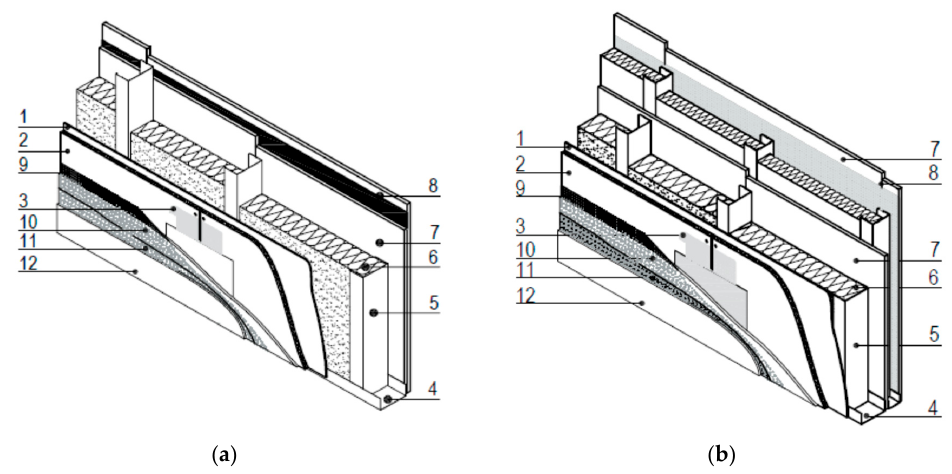
Figure 5. ( a ) façades with single layer of studs; ( b ) façades with double layer of studs, Drywall non-structural architectural components: façades; 2 = waterproof cement panels; 4 = track profile; 5 = stud profile; 6 = thermal insulation material; 7 = gypsum panel.